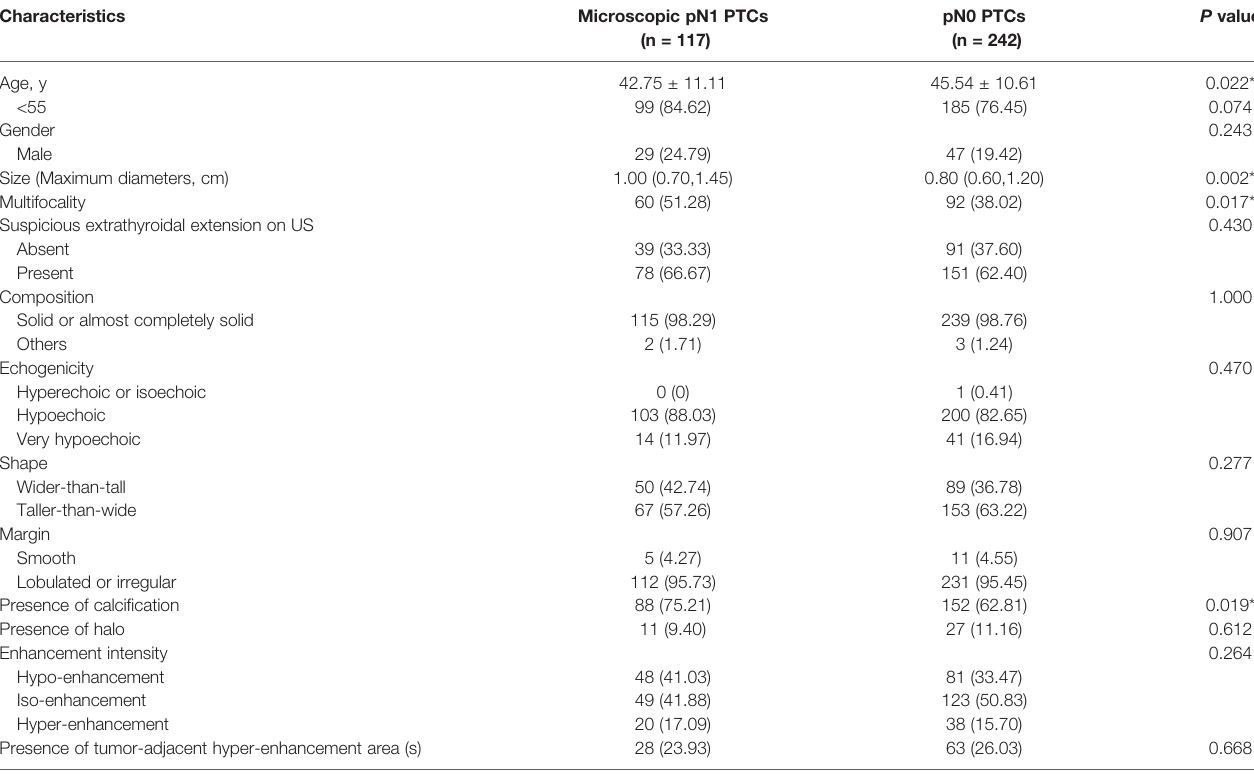
TABLE 3 | Clinical and sonographic characteristics of microscopic pN1 PTCs and pN0 PTCs.